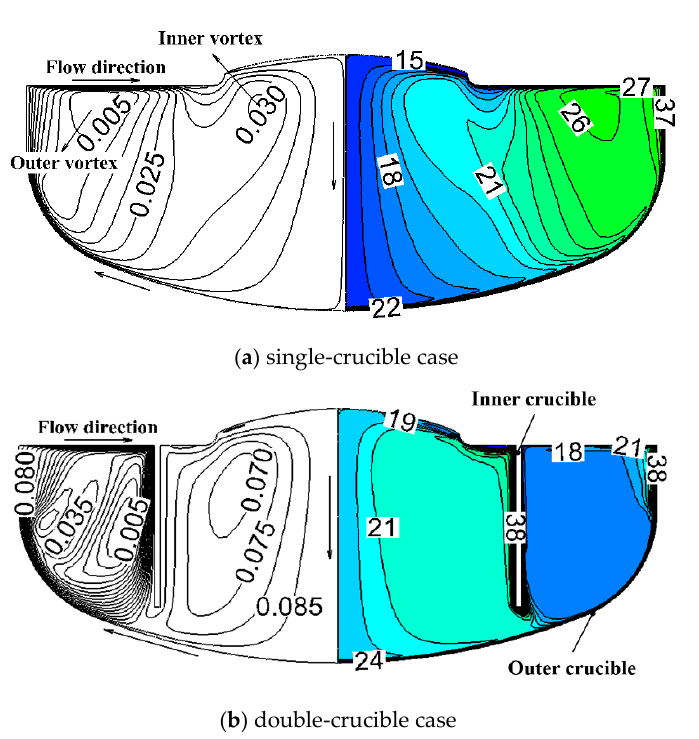
Figure 3. The stream function (left) and oxygen concentration (right, ppma) in the melt: ( a ) the case with the conventional single-crucible method, ( b ) the case with the double-crucible method.